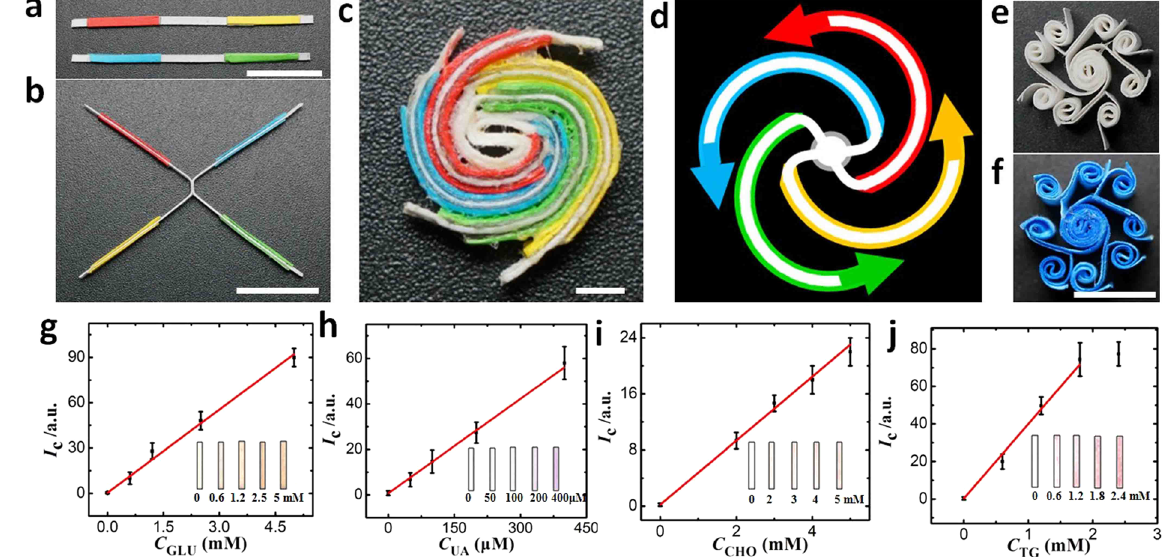
Figure 4. ( a , b ) Photographs of the paper strips attached with tapes for the device fabrication. ( c ) The resulted 2D vPAD for colorimetric detection of four analytes (GLU: glucose, UA: uric acid, CHO: cholesterol, TG: triglycerides), scale bar: 2 mm. The colors of the paper strips are from the double-sided adhesive tapes used to assemble the device. ( d ) The resulted fluidic channels and flow direction (indicated by arrows) of aqueous sample in the device. ( e ) The vPAD for carrying out eight parallel assays. ( f ) The vPAD after introduction of 0.010 M coomassie brilliant blue solution. The assays results measured from the 2D vPAD for colorimetric detection of four analytes: ( g ) GLU: glucose; ( h ) UA: uric acid; ( i ) CHO: cholesterol; and ( j ) TG: triglycerides. The arrow bars indicate the standard deviation of three replicated